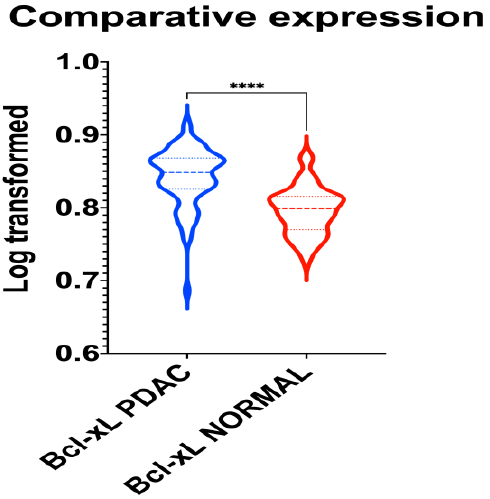
A unique PubMed GEO PDAC microarray dataset was identified (GSE62452), which included a total of 130 samples (PDAC: 69; adjacent non-tumor tissue control: 61), with a